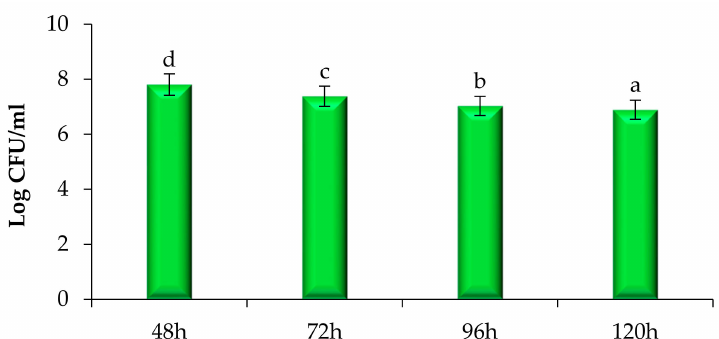
Figure 6. Time–kill kinetics of Woodfordia fruticosa flower’s dry extract against the growth of pathogenic Candida albicans during different time intervals. Data are presented as means ± SEM ( n = 3); a–d: Means within the column with different lowercase superscripts are significantly different ( p <